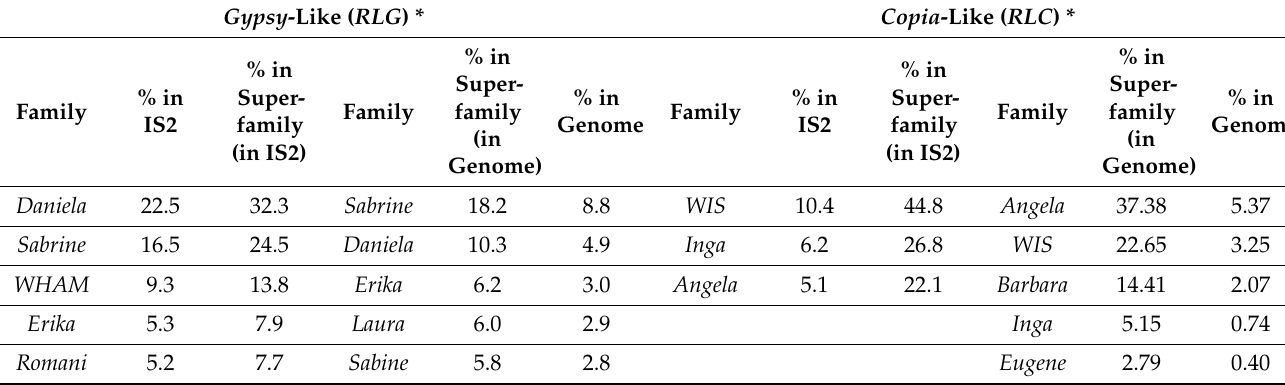
Table 1. Contribution of the most abundant class I and class II families to the IS2 and genome of rye. Gypsy -Like ( RLG )